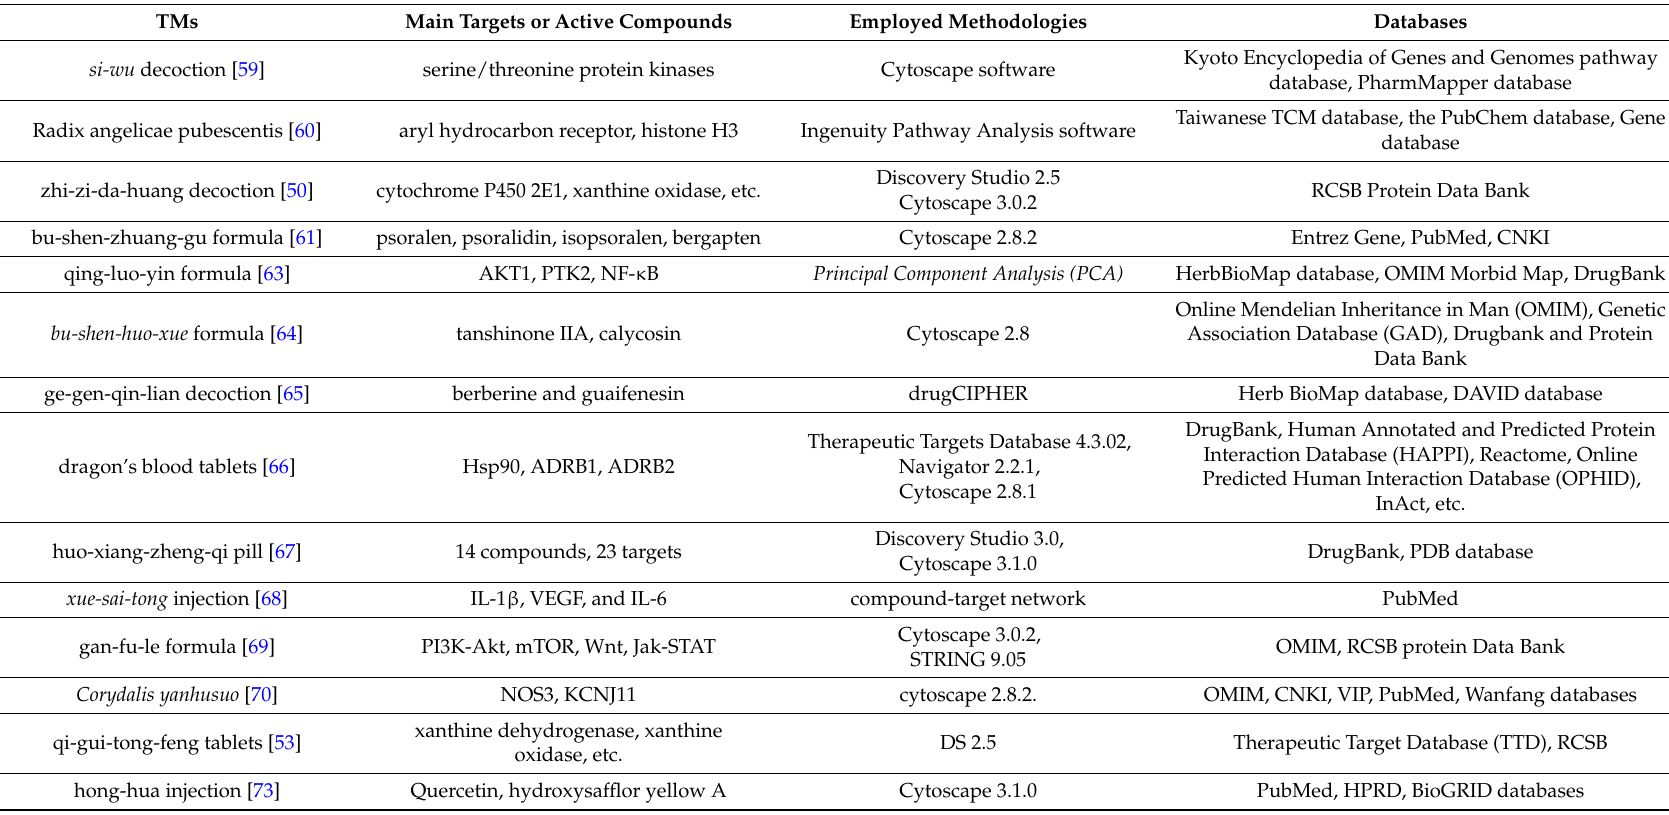
Table 1. Summarized description of some traditional medicines (TMs) and relevant methodologies employed in network